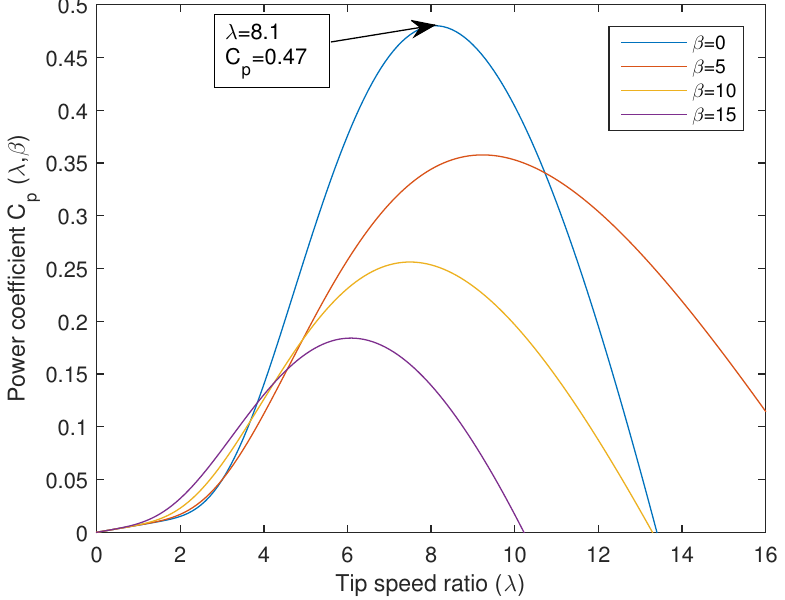
Figure 2. The power coefficient C p versus the tip speed ratio λ for several values of the pitch angle β .